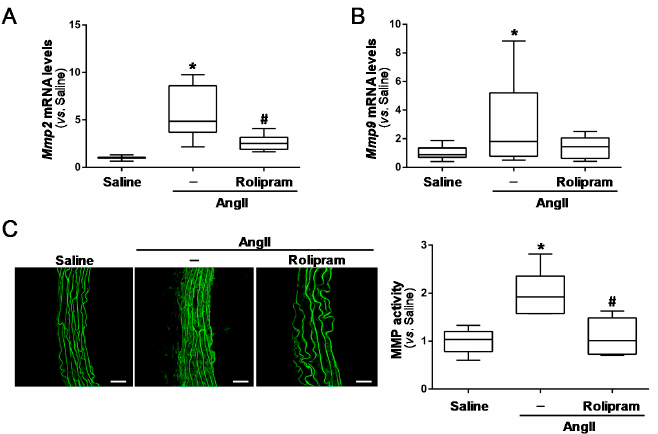
Figure 8. Rolipram attenuates the increase in MMP activity triggered by AngII in ApoE − / − mice. ApoE − / − mice were infused with saline solution or AngII (1000 ng/kg/min) for 28 days. The mice challenged with AngII were treated or not with rolipram (3 mg/kg/day). ( A , B ) The Mmp2 ( A ) and Mmp9 ( B ) mRNA levels were analysed by real-time PCR. The data are presented as box and whisker plots. The box extends from the 25th to the 75th percentile, and the median is indicated by a horizontal line. The whiskers represent the maximum and minimum values (saline-infused mice n = 8; AngII-challenged mice, n = 12; AngII-challenged mice treated with rolipram, n = 9). ( C ) The MMP activity analysed by in situ zymography in the abdominal aortas from each experimental group. Representive images are shown (Bars: 50 µm). The boxplot on the right shows the quantification of the MMP activity (saline-infused mice n = 5; AngII-challenged mice, n = 6; AngII-challenged mice treated with rolipram, n = 6). In A to C, p < 0.05: * vs. saline-infused mice; # vs. AngII-challenged mice.